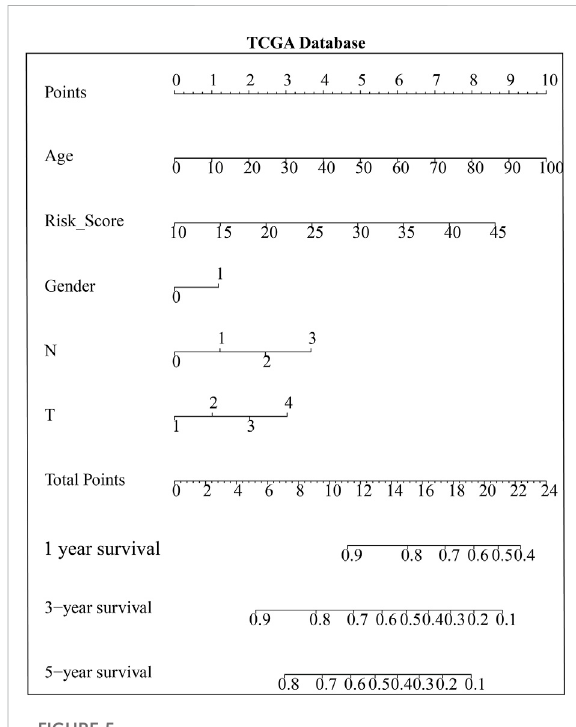
FIGURE 5 Nomogram based on the risk model and clinicopathological factors in TCGA database.